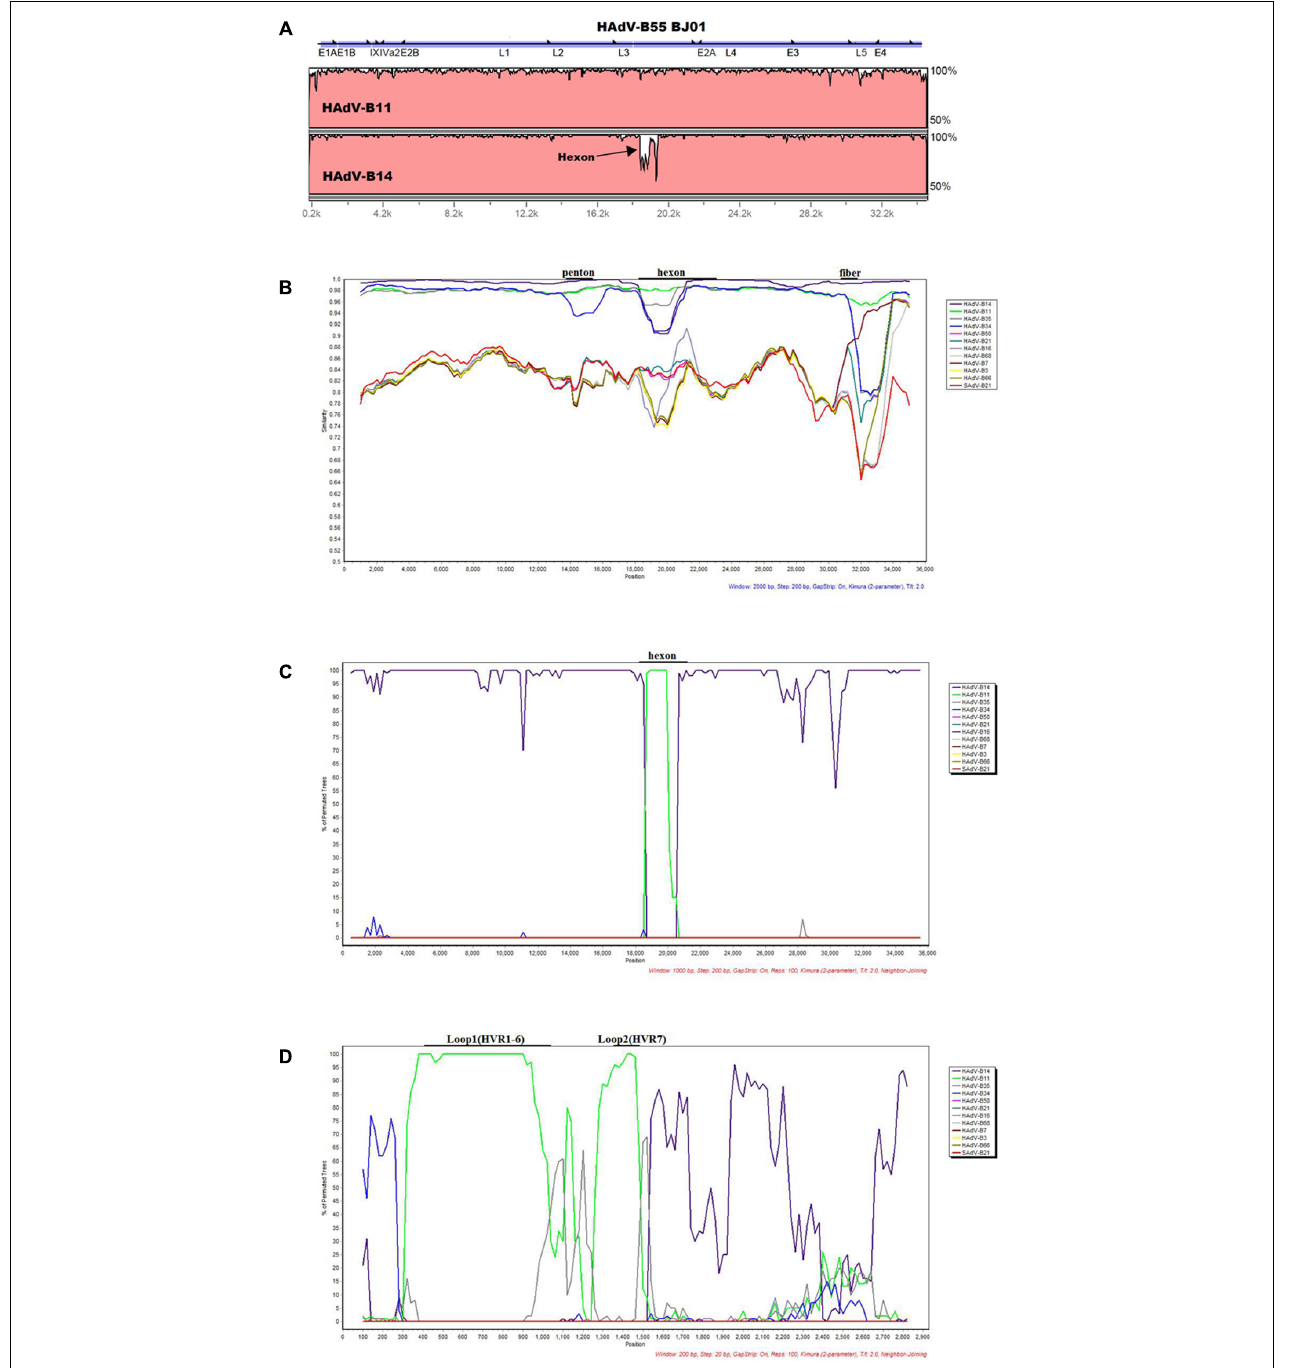
FIGURE 2 | Genome and recombination analysis of HAdV-B55 Strain BJ01. (A) Global pairwise alignment of HAdV-B55 (BJ01) with HAdV-B11 and HAdV-B14 using mVISTA LAGAN. Transcription units are shown above the graph by black arrows relative to their position and orientation in the HAdV genome. The y-axis represents the sequence similarity and the genome positions are indicated on the x-axis. (B) Simplot and (C) Bootscan analysis of the complete genomes of strain BJ01 compared to other species B adenoviruses. (D) Bootscan analysis of the hexon genes compared with other HAdV-B types. Parameters are as follows: 100 repetitions; Kimura distance model; neighbor-joining tree model; (B) 2,000-bp window, 200-bp step; (C) 1,000-bp window, 200-bp step; (D) 200-bp window, 20-bp step. Genome nucleotide positions are noted along the x-axis, and the sequence similarities are indicated along the y-axis. The landmarks above each graph demonstrate the approximate positions of the major capsid protein genes. (B)/(C)/(D) : Main genomes used were marked in the graph. Colors: violet, HAdV-B14; bright green, HAdV-B11; dark gray, HAdV-B35; blue, HAdV-B34; pink, HAdV-B50; blue green, HAdV-B21; gray-violet, HAdV-B16; light gray, HAdV-B68; dull-red, HAdV-B7; yellow, HAdV-B3, brown, HAdV-B66; bright red, SAdV-B21.